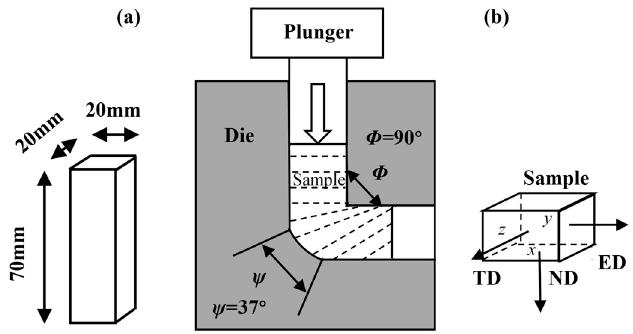
Figure 1. Schematic illustrations of ( a ) the geometry of the rectangular samples prepared for Equal channel angular pressing (ECAP); ( b ) ECAP process with reference axes. ED, TD and ND represent the extrusion direction, transverse direction and the normal direction to x -plane, respectively.